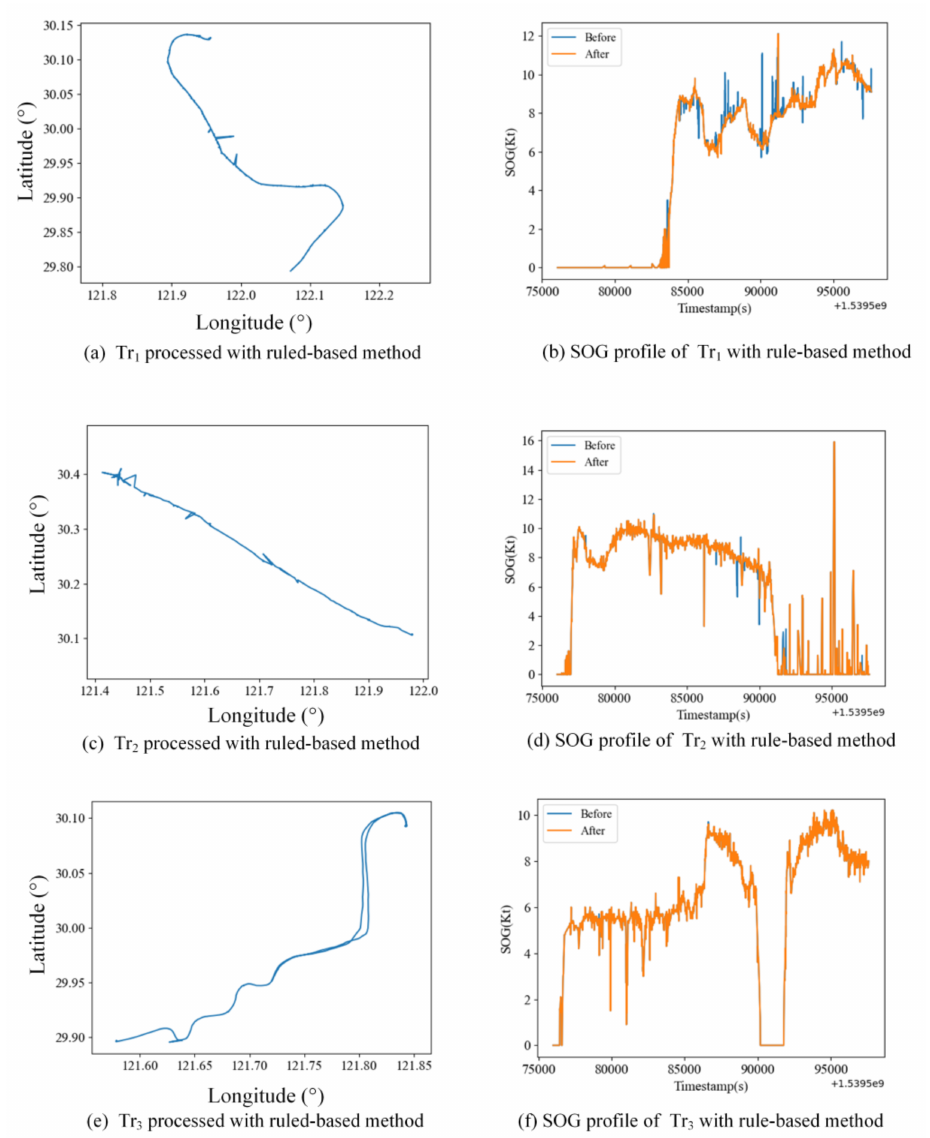
Figure 12. Results of the rule-based